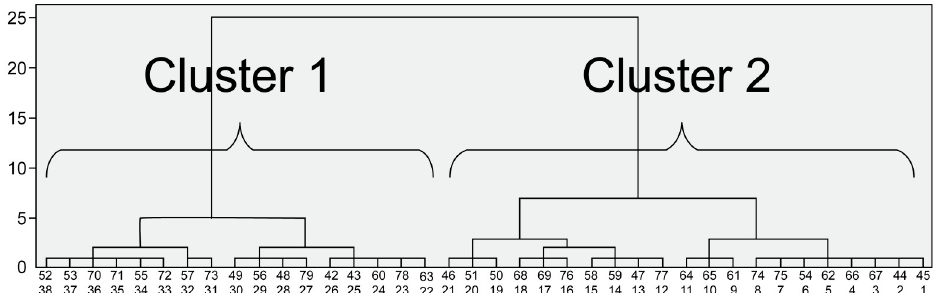
Fig 3. Dendrogram representing the minimum variance hierarchical classification of the Functional Reach Test patterns in older participants (Ward method; Euclidian distances). https://doi.org/10.1371/journal.pone.0266195.g003 determined using Welch’s t-test because they showed a normal data distribution but did not show homogeneity of variance. Other parameters were compared using the unpaired t -test, as the data showed a normal distribution and had homogeneity of variance.